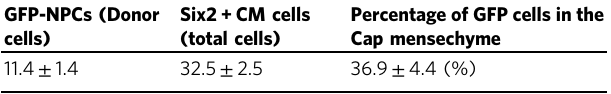
mean ± SEM ( n = 12) The fraction of Six2-positive green cells (yellow spot) integrated into the CM of the total Six2- positive cells (red and yellow spot) is presented as a percentage. Nephron progenitor cells- expressing GFP transplanted in the wild-type metanephros (MN). Representative image is Fig. 2a